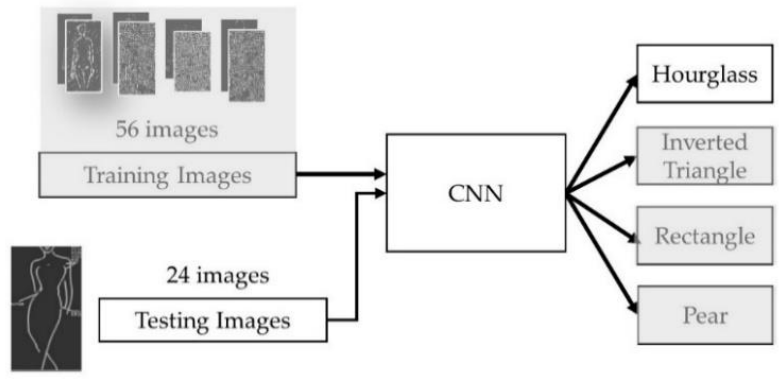
Figure 13 . Training and testing procedure of the CNN model using the acquired database.